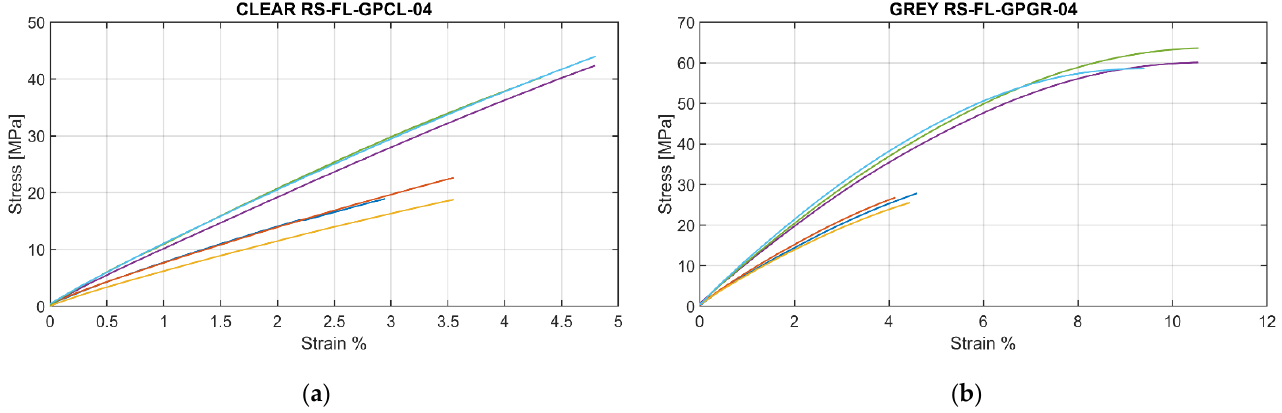
Figure 4. Stress-strain curve green and post-cure of Standard Clear ( a ) and Grey Pro ( b ) Resins. Lines are coloured as in Figure 2.